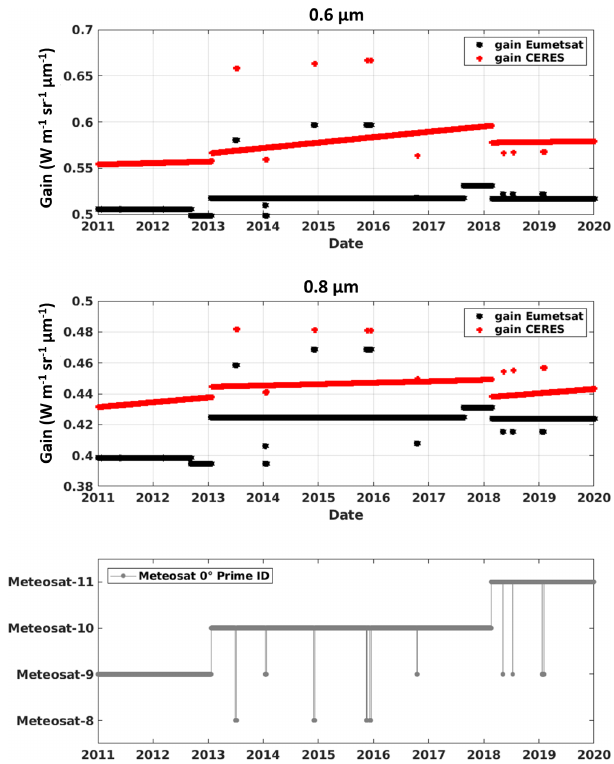
Figure B1. Relative mean bias errors of simulated clear-sky reflectances at the top of the atmosphere ρ clear (simulation measurement / measurement) for channels 0.6µm (a) and 0.8µm (b) and for each BSRN